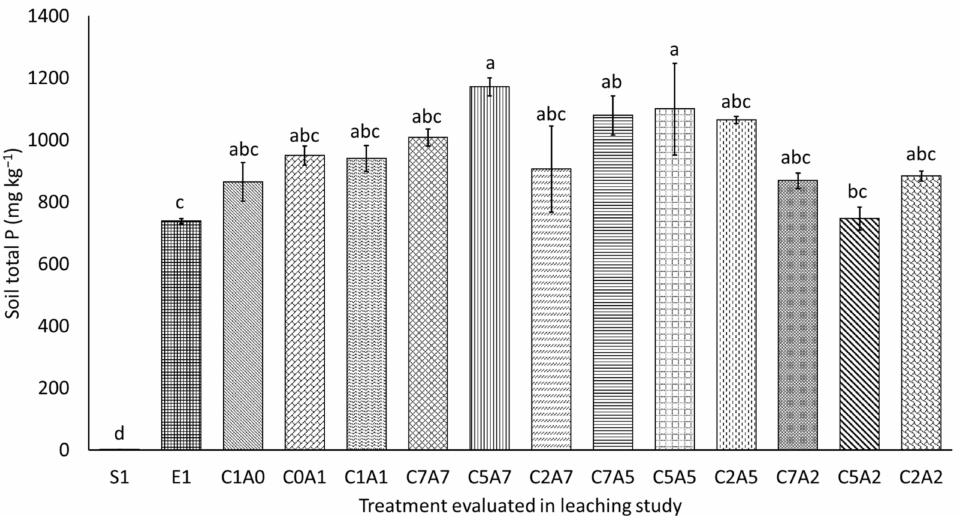
Figure 12. Treatments on soil total phosphorus after thirty days of leaching, where S1: soil only; E1: soil with ERP only; C1: 100% charcoal; C0: 0% charcoal; C7: 75% charcoal; C5: 50% charcoal; C2: 25% charcoal; A1: 100% sago bark ash; A0: 0% sago bark ash; A7: 75% sago bark ash; A5: 50% sago bark ash; A2: 25% sago bark ash. Means with different letter(s) indicate significant differences between treatments according to Tukey’s HSD test at p ≤ 0.05, that is, a > b > c. Bars represent the mean values ± SE.